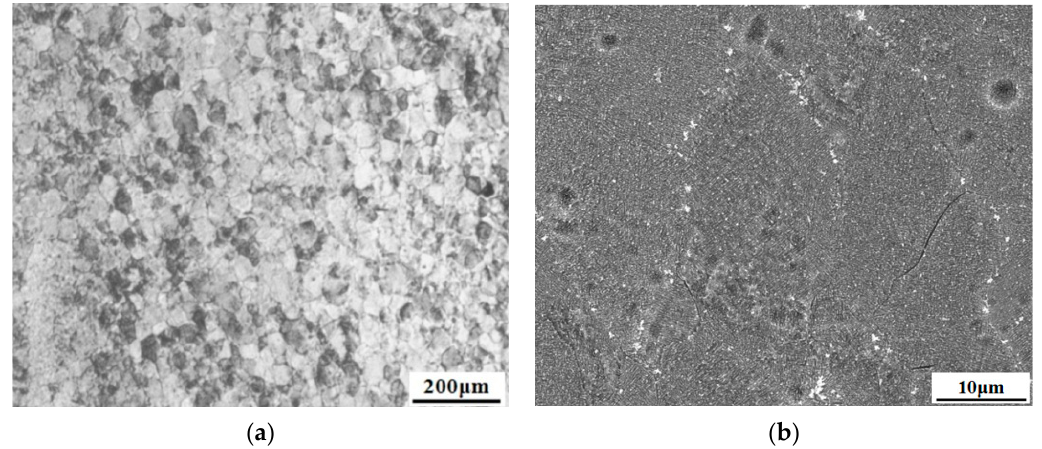
Figure 10. Microstructure in the weld zone (WZ) of the joint after heat treatment. ( a ) Grain morphology ( b ) Microstructure morphology.